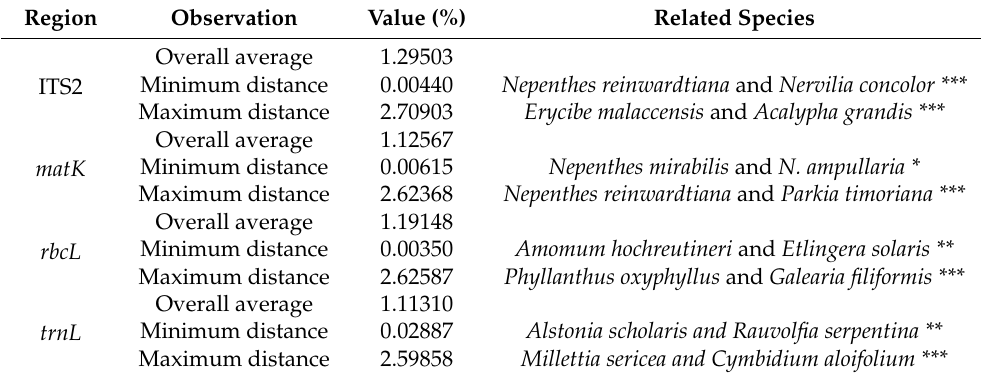
Table 4. K2P pairwise genetic distances (%) of each region at different species